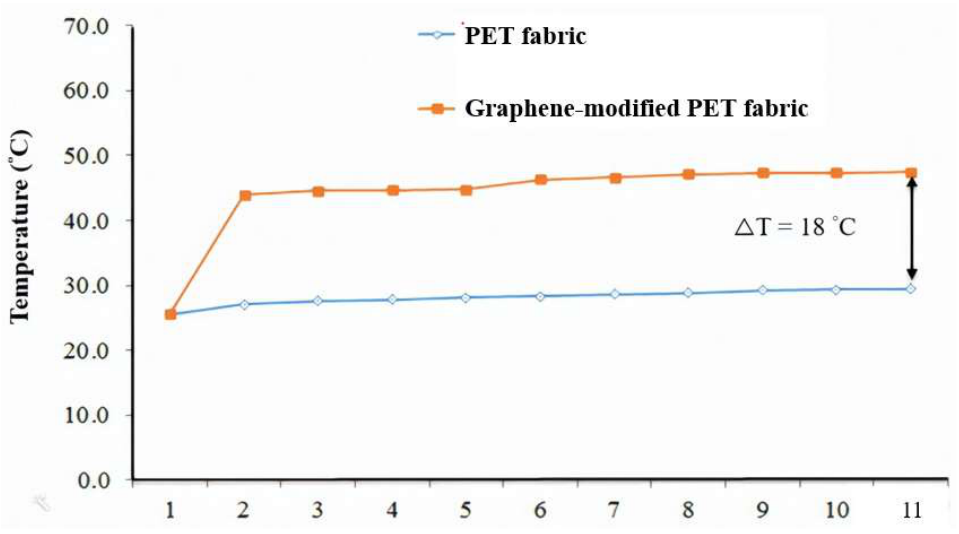
Figure 5. Far-infrared temperature rise curve of the optimized modified polyester yarn.